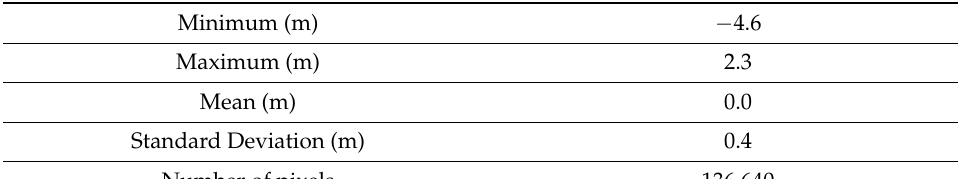
Table 1. Topo-to-Raster algorithm interpolation error statistics.